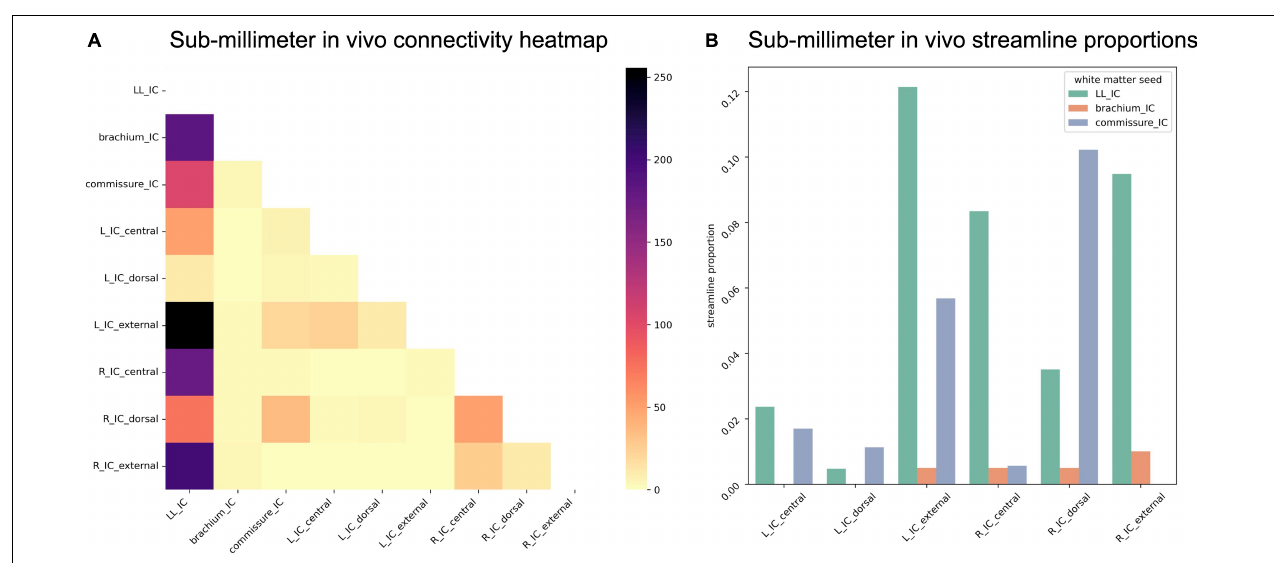
FIGURE 8 | (A) Connectivity matrix of post mortem inferior colliculus (IC) subdivisions and adjacent white matter tracts (values indicate number of streamlines); (B) proportion of streamlines reaching each white matter region for each IC subdivision.